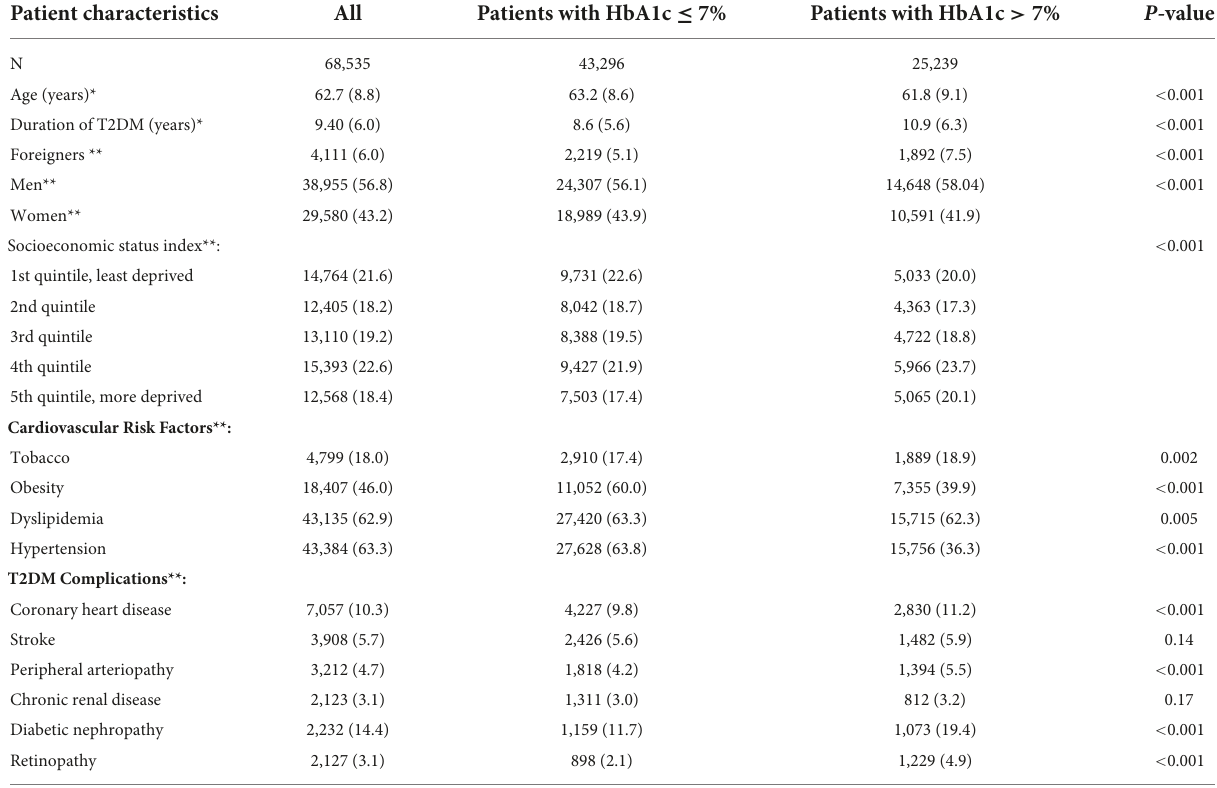
TABLE 1 General characteristics of the population according to their achievement of the glycemic